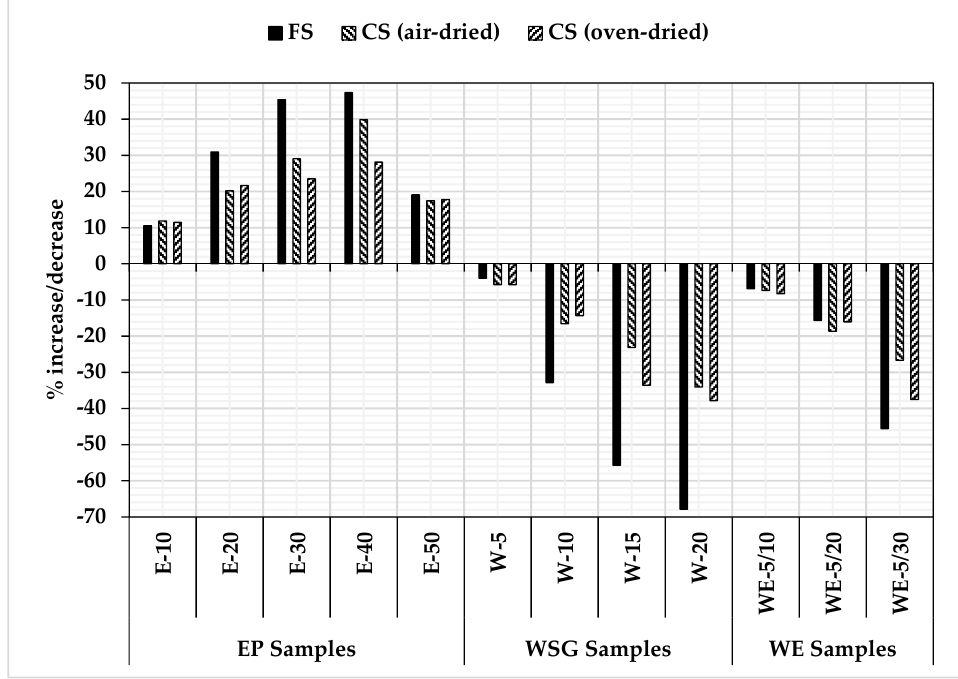
Figure 12. Comparison of flexural strength (FS) and compressive strength (CS) between the control and waste-incorporated